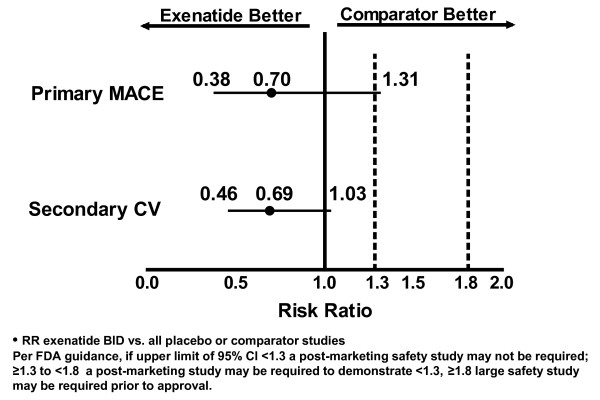
Risk of primary MACE and secondary CV endpoints with exenatide BID relative to pooled comparators.